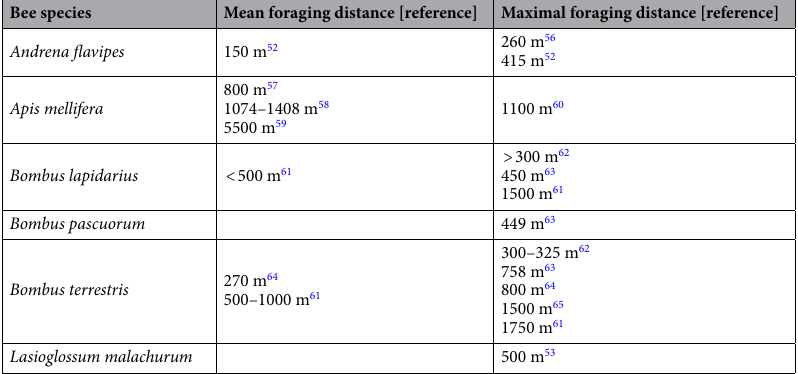
Table 1. Literature references on mean and maximal foraging distances of some bee species, which were observed and identified in the focal sunflower fields during this